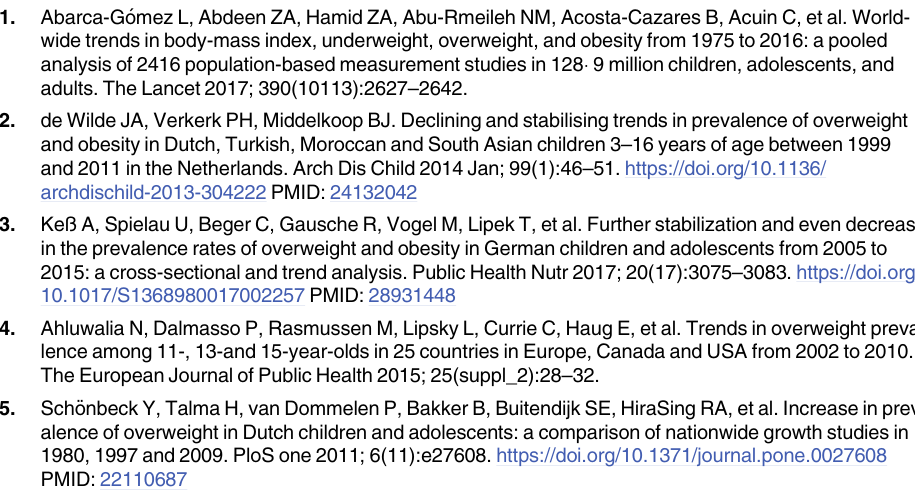
S1 Table. Summary of items for assessing background characteristics and health-related behaviors. S2 Table. Analyses of